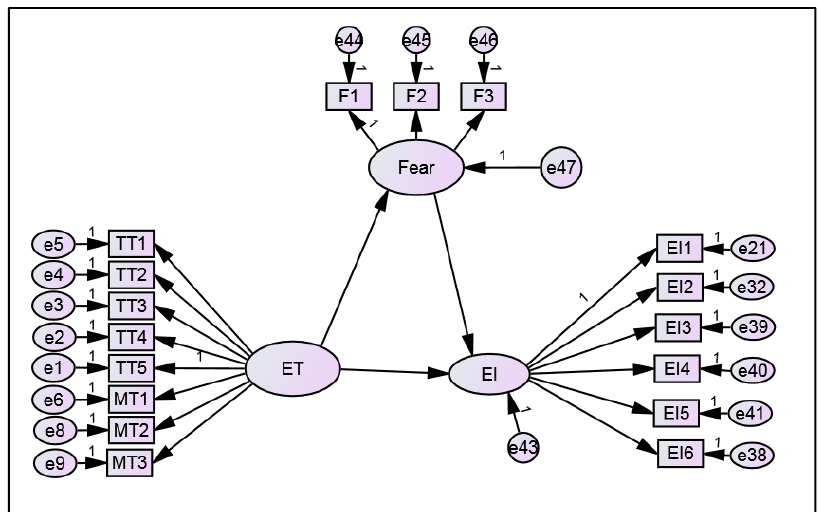
Figure 2. Structural model.